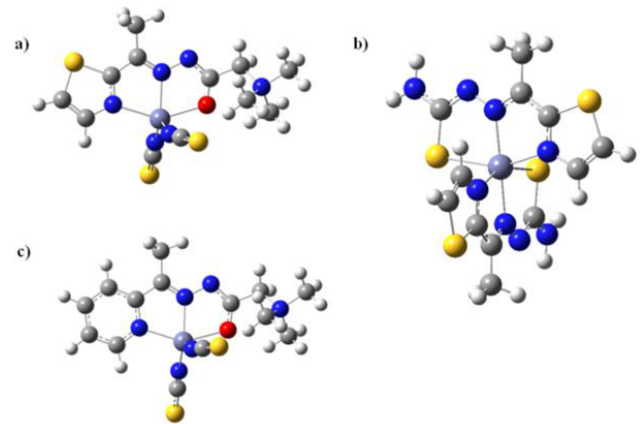
Figure 3. Density functional theory (DFT) optimized geometries of: ( a ) [Zn L 1 (NCS) 2 ] ( 1 ); ( b ) [Zn( L 2 ) 2 ] ( 2 ); and ( c ) [Zn L 3 (NCS) 2 ] ( 3 ).